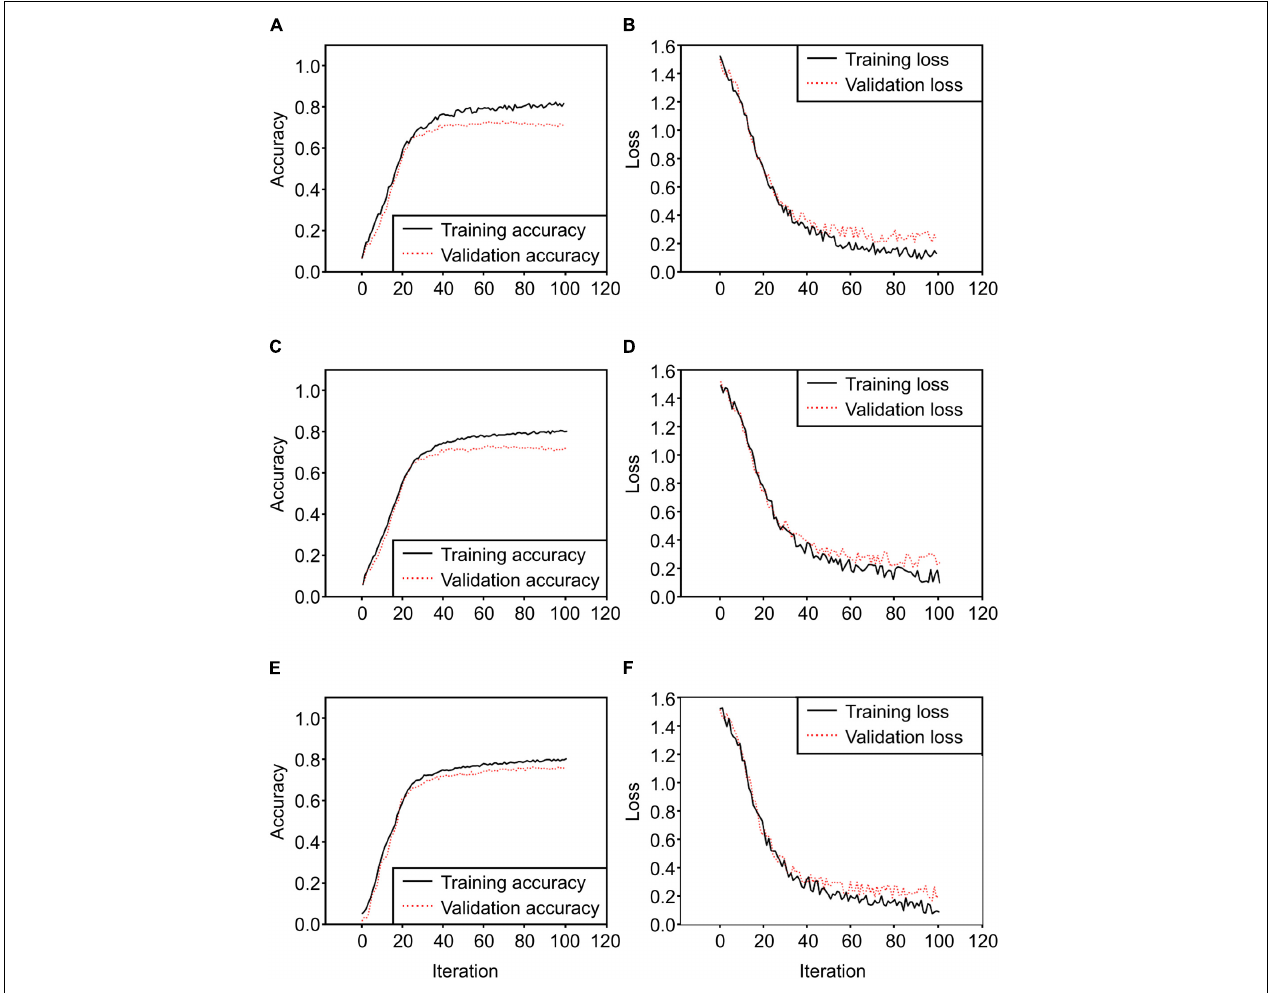
FIGURE 11 | 2D CNN model training results [ (A) training accuracy of the 2D CNN model proposed in this study, (B) loss of the 2D CNN model, (C) accuracy of the 2D CNN model with the VGGnet-19 structure, (D) loss of the 2D CNN model with the VGGnet-19 structure, (E) accuracy of Resnet50, (F) loss of Resnet50].